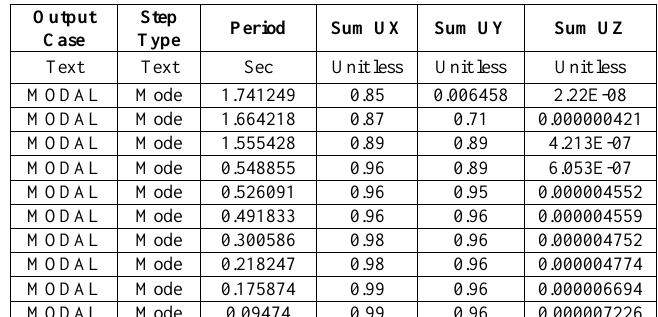
Table 3: modal participating mass ratios.